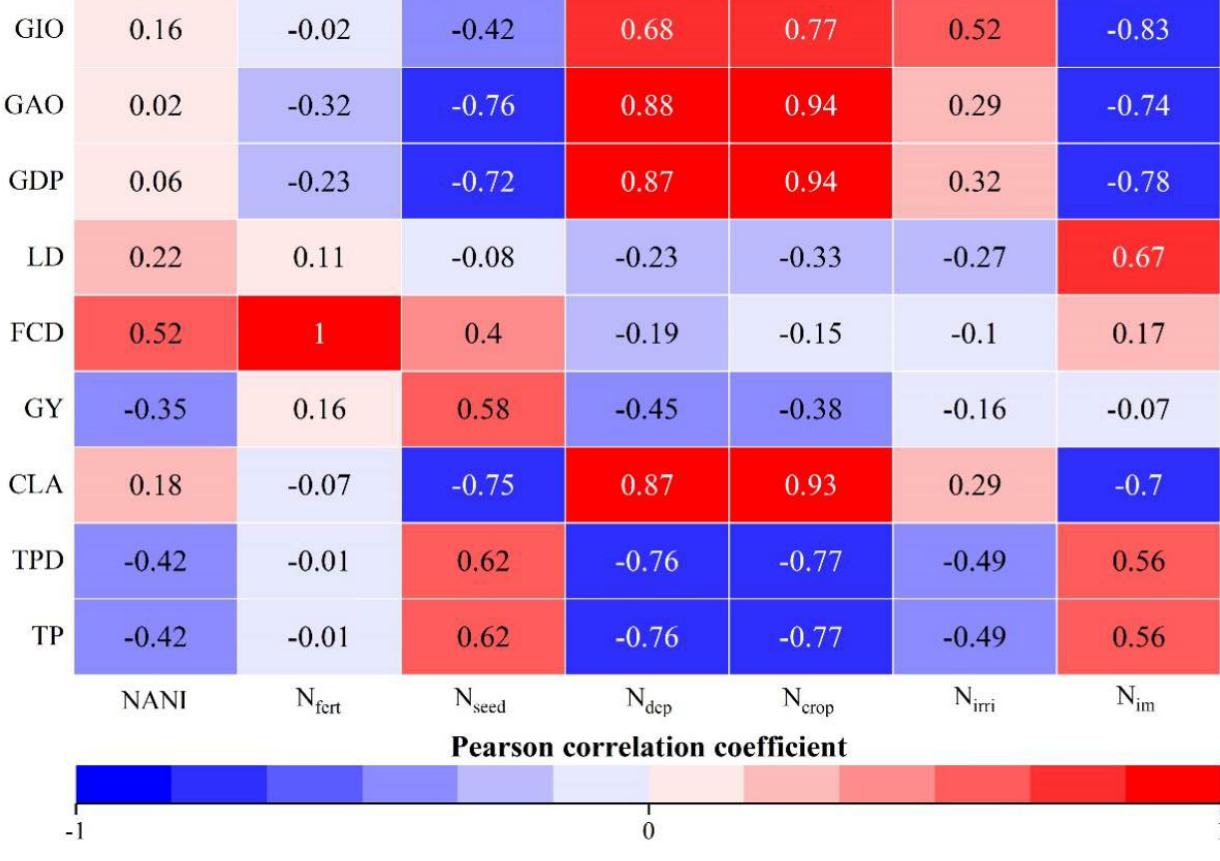
Table 2. Regression analysis between riverine N export ( y ) and independent variables ( x ) in the UNW from 2005 to